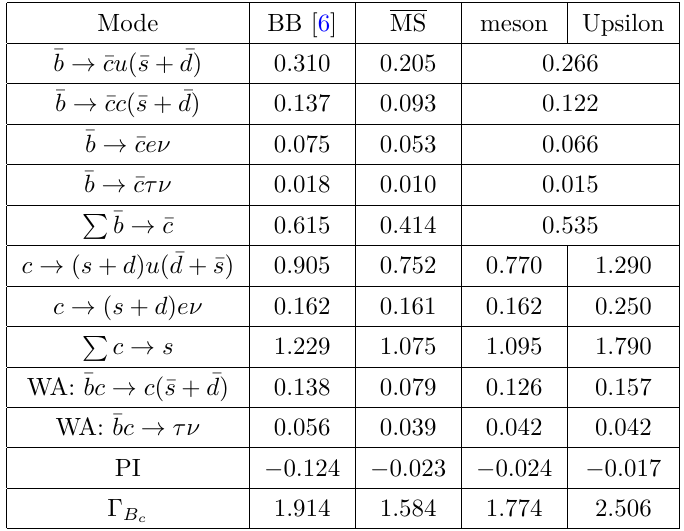
Table 3 . Results for the partial decay rates in ps − 1 . The results from BB in [6] in the second column are compared to the results in this paper given in the MS, meson and Upsilon schemes. The hadronic WA and PI contributions of our results include the QCD penguin contributions, which were neglected in BB.